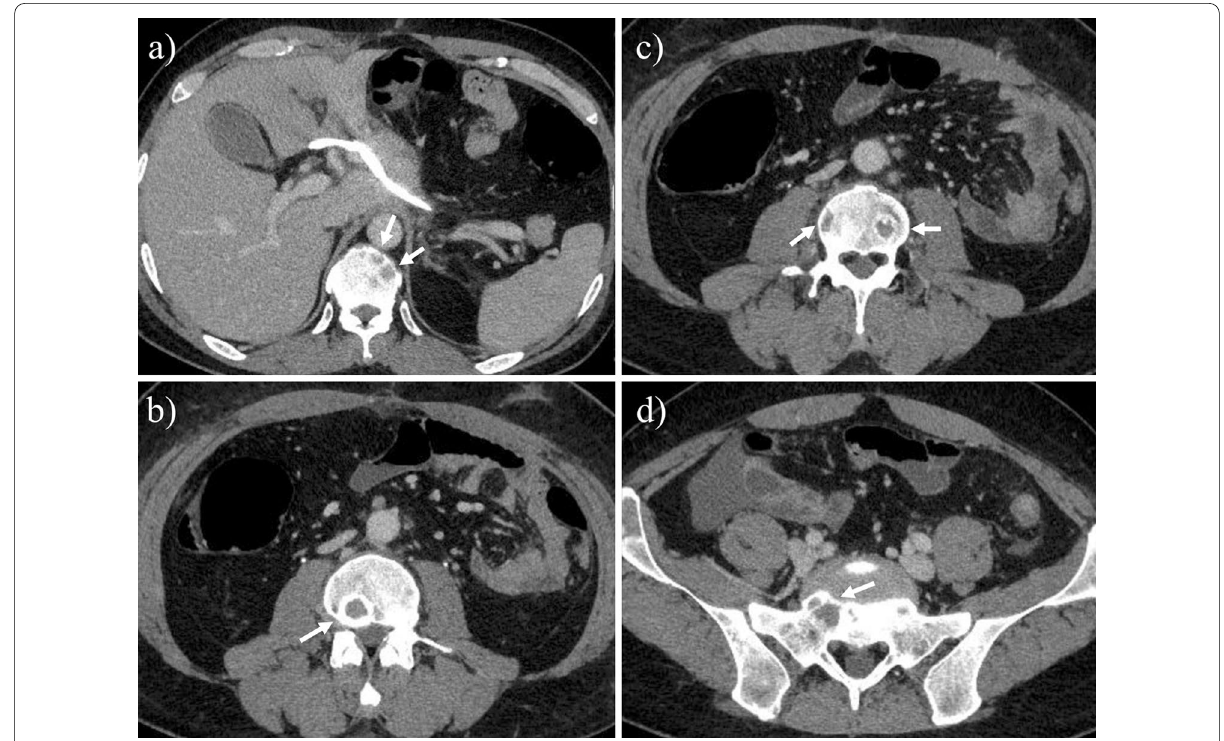
Fig. 3 Postoperative CT. Multiple, widespread, low-density masses were seen in the vertebrae (arrow)